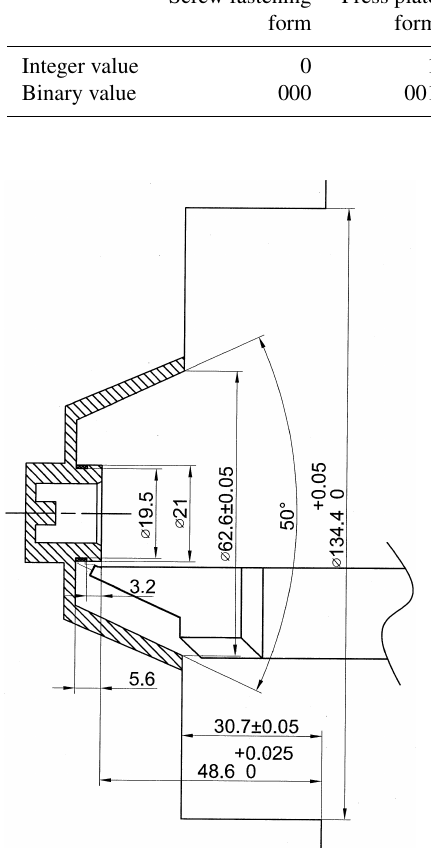
Figure 4. Test sample A0050 part slot size.